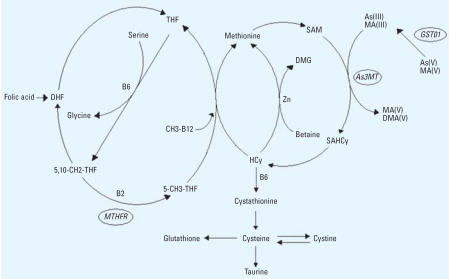
The methionine and folic acid cycles and the metabolic pathway of arsenic. Abbreviations: 5-CH3-THF, methyl tetrahydrofolate; 5,10-CH2-THF, methylenetetrahydrofolate; As3MT, arsenic (+3 oxidation state) methyltransferase; B2, vitamin B2 (riboflavin); B6, vitamin B6; CH3-B12, methylated vitamin B12; DHF, dihydrofolate; DMG, dimethylglycine; GSTO1, glutathione-S-transferase omega; HCy, homocysteine; SAHCy, S-adenosyl homocysteine; THF, tetrahydrofolate; Zn, zinc.